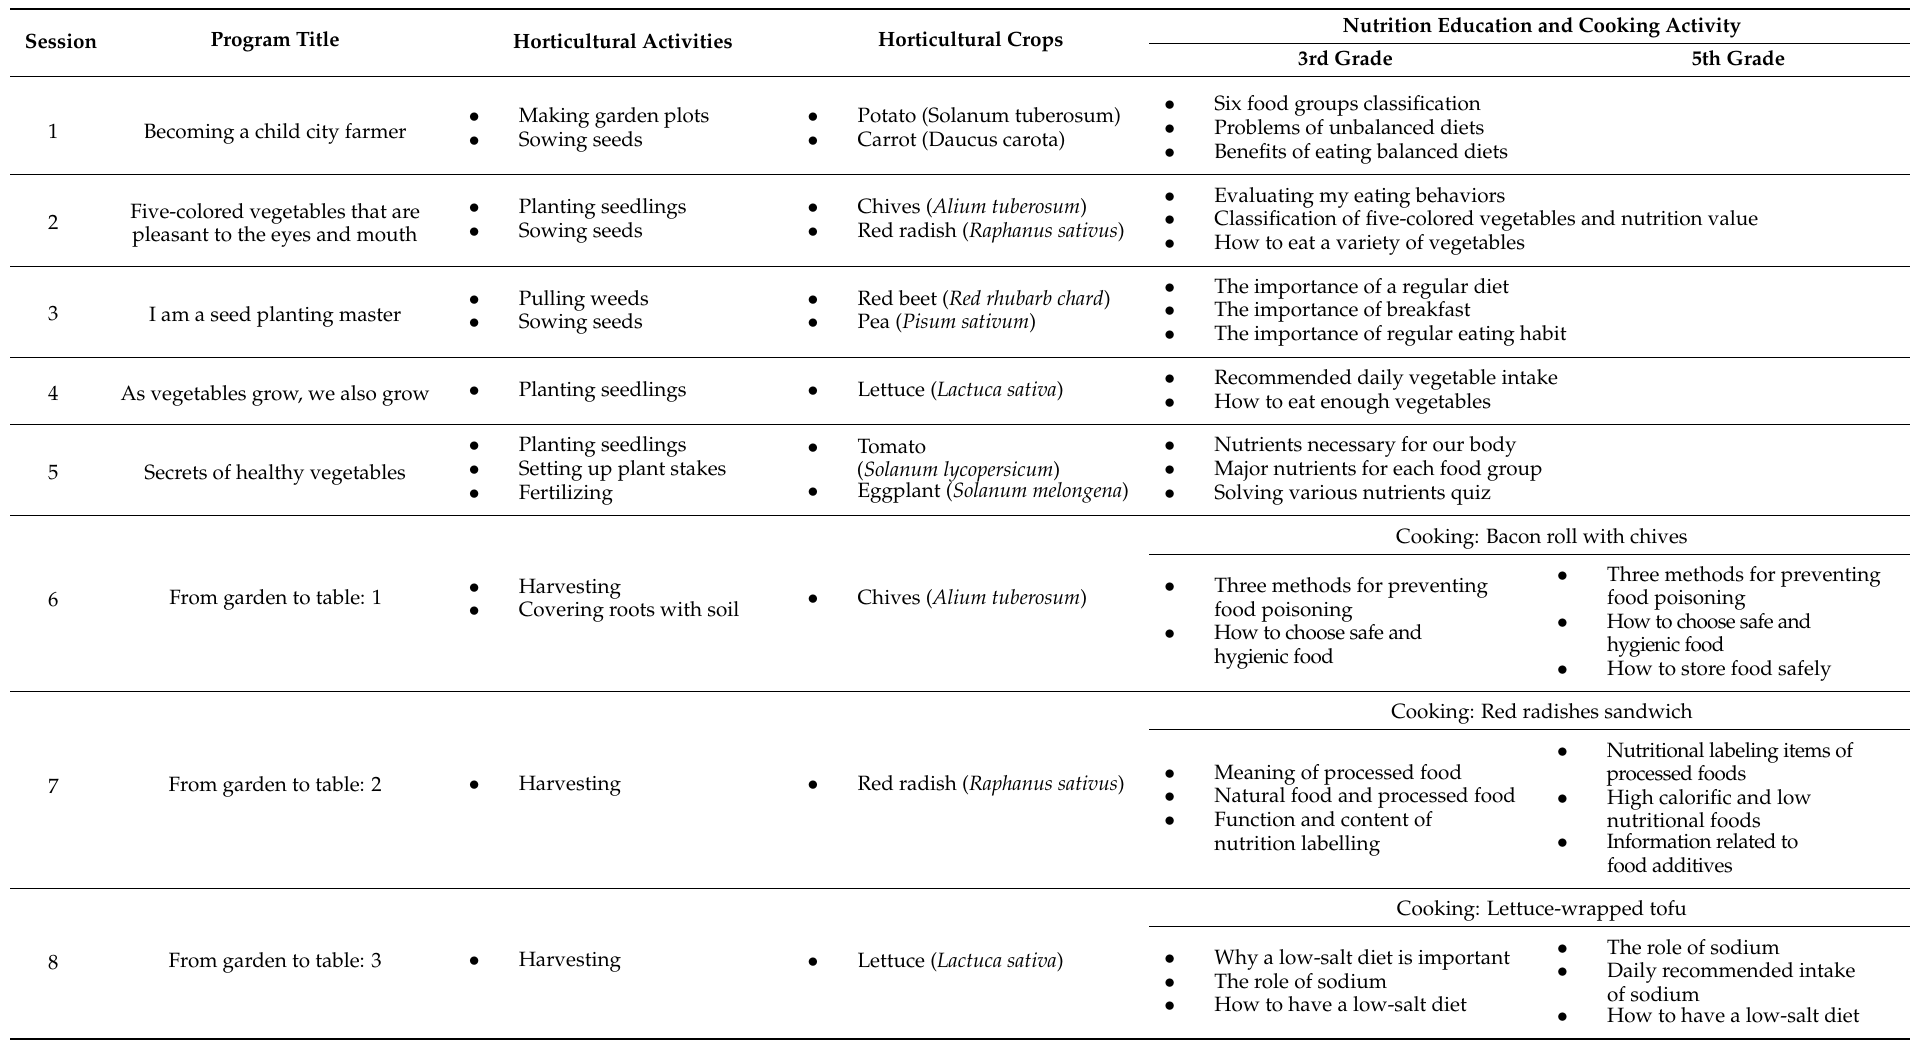
Table 1. Development of the horticultural activity program for improving children’s eating behavior for vegetables (modified version of the program developed by Kim and Park